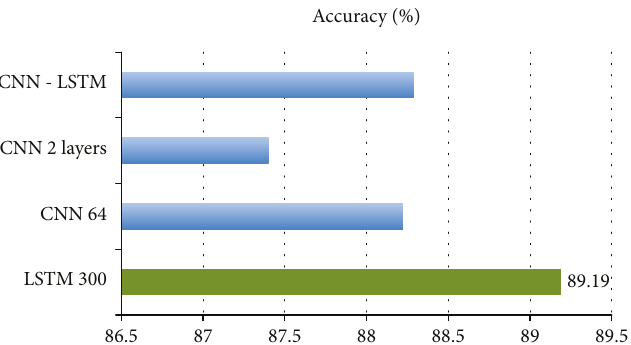
Figure 10: Comparison of LSTM and CNN models.